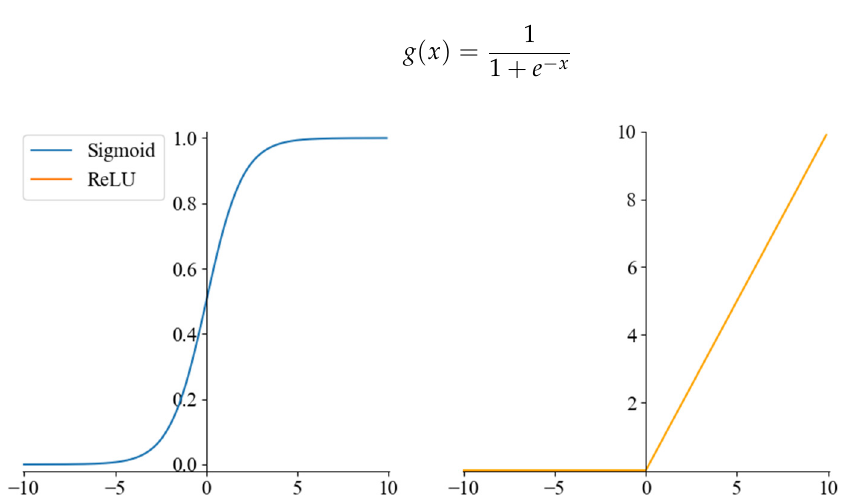
Figure 4. The Sigmoid and ReLU activation function.